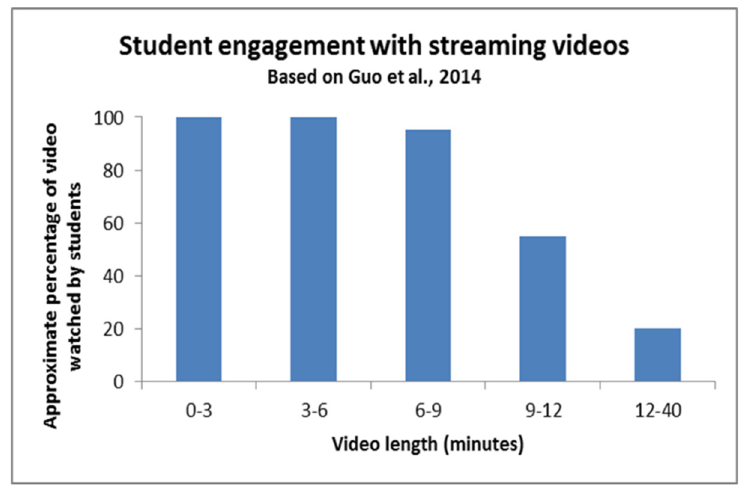
Figure 3. Educational video view rate (edited based on [57]).